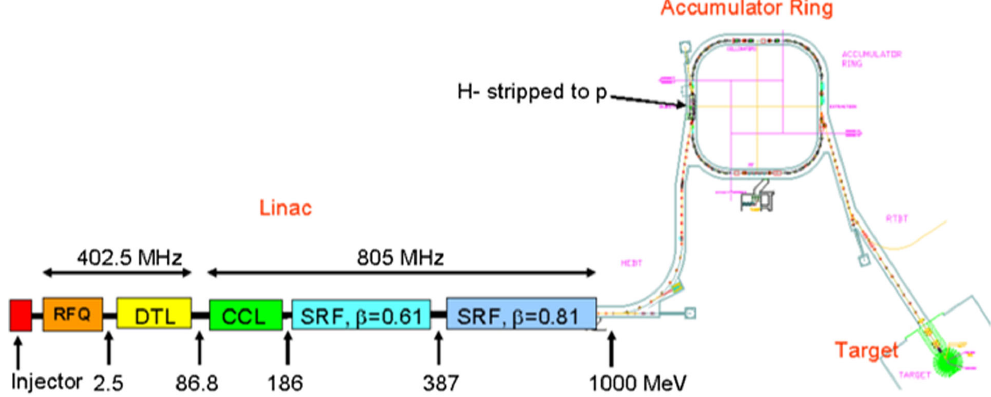
FIG. 1. Layout of the Spallation Neutron Source facility.